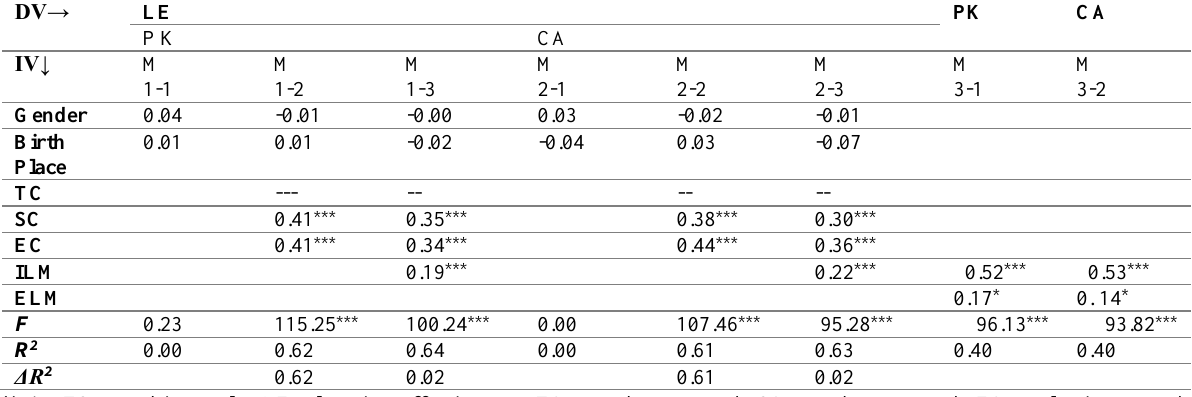
Table 3: The Mediating Effect of ILM in the relationship between TS and LE